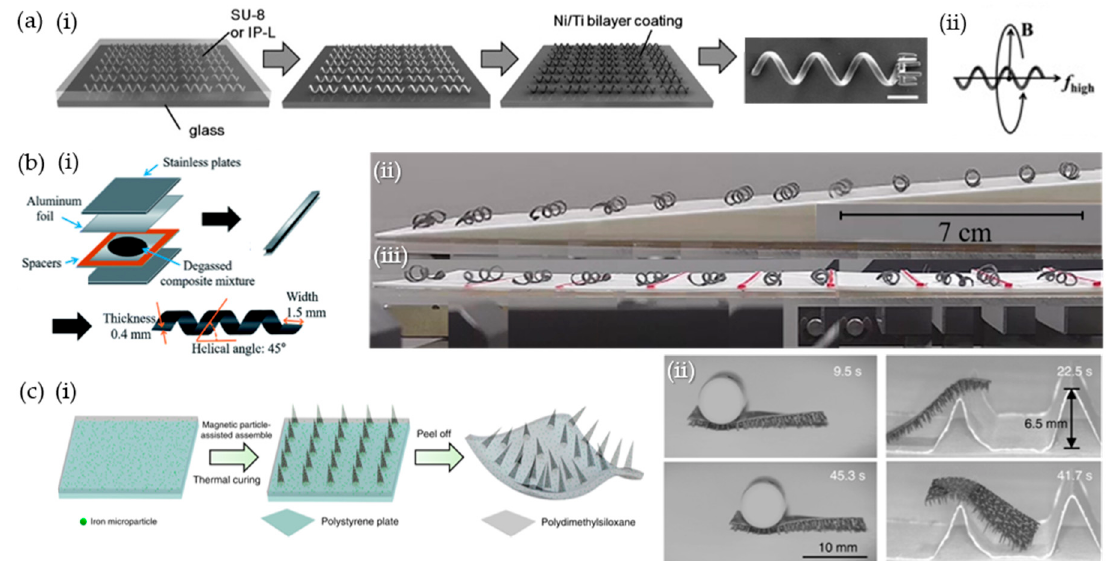
Figure 3. Geometry-induced locomotion of magnetic soft robots. ( a ) Helical soft robots produced using the dynamic light writing process when a photoresist polymer is used, followed by Ni/Ti bilayer coating: ( i ) scanning electron microscopy (SEM) image of helical micromachines with a microholder (scale bar: 10 μ m), and ( ii ) principle of corkscrew motion. ( b ) Fabrication scheme for molding a helical geometry via ( i ) two-step polymerization, and ( ii ) ascending performance on uphill obstacles, and ( iii ) discrete walls. ( c ) ( i )